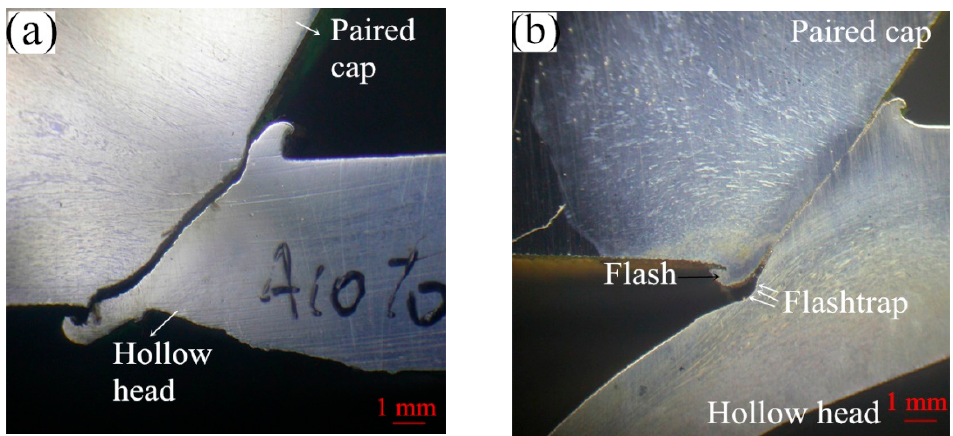
Figure 6. Bad weld quality of HHSV specimens after friction welding process: ( a ) macroscopic crack; ( b ) bad welding metallurgical bonding and bad flash.